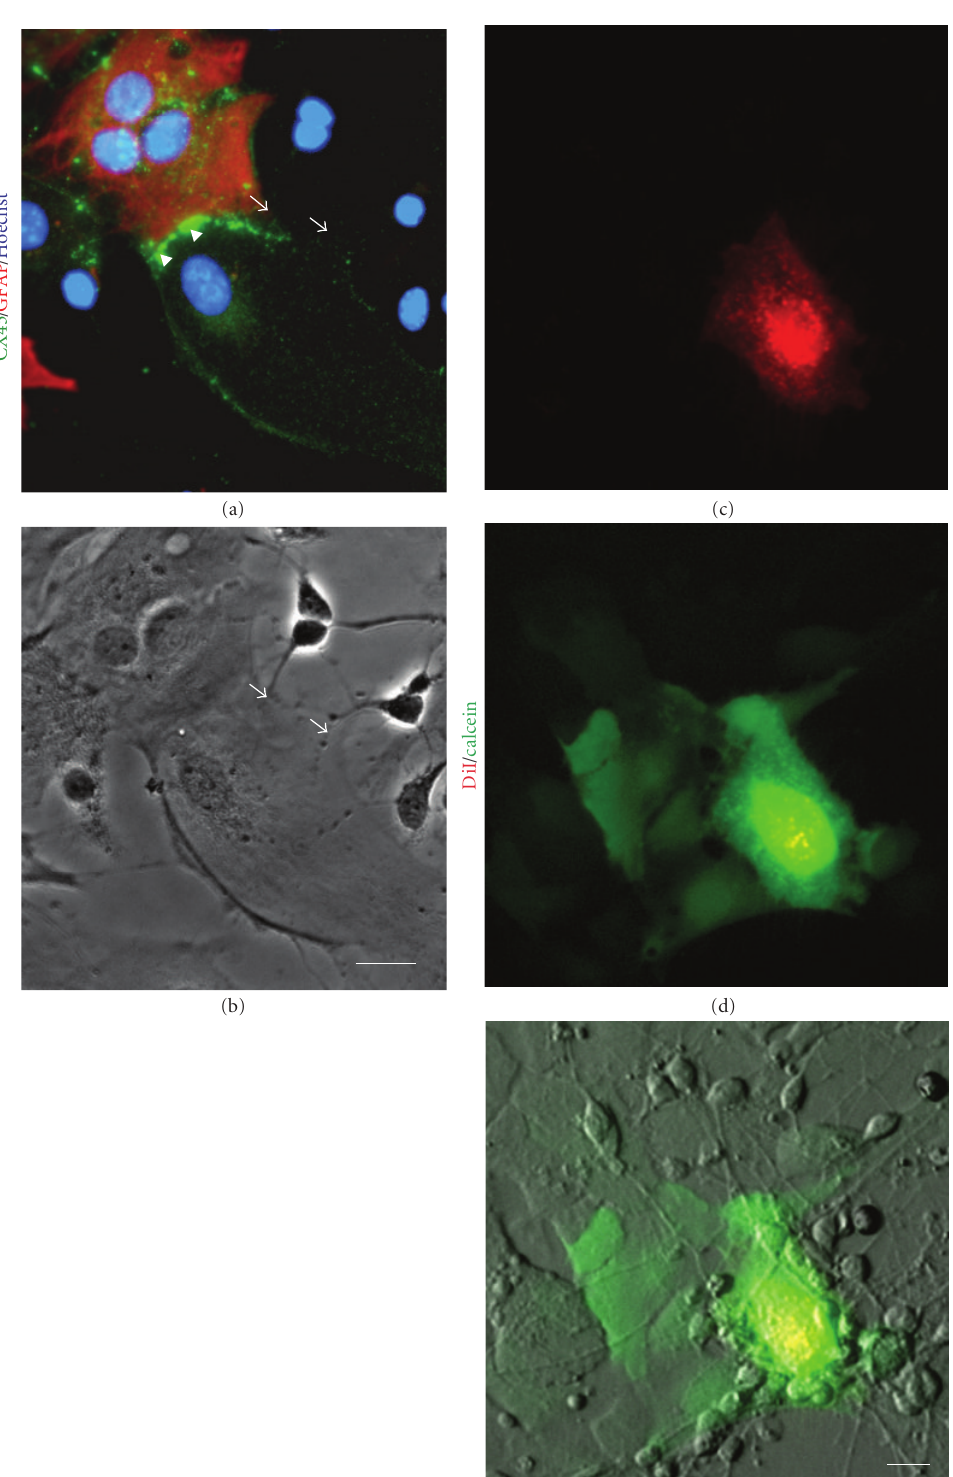
Figure 5: AF cells selectively establish intercellular communication with cortical astrocytes. (a)-(b) Cocultures of AF cells with cortical cells. Immunostaining showed abundant levels of Cx43 protein (green) at the junction between AF cells and cortical astrocytes (GFAP (red); see arrowheads), whereas there was only a limited amount of staining detected at the boundary with neurons (arrows). Scale bar: 10 μ m. (c)–(e) AF cells were preloaded with DiI (red) and calcein (green) and plated as a single cell suspension on cortical cultures to examine metabolic coupling. AF cells readily established functional gap junctional communication with astrocytes within 4 hours, as indicated by calcein transfer, a phenomenon not observed between AF cells and neurons. Scale bar: 10 μ